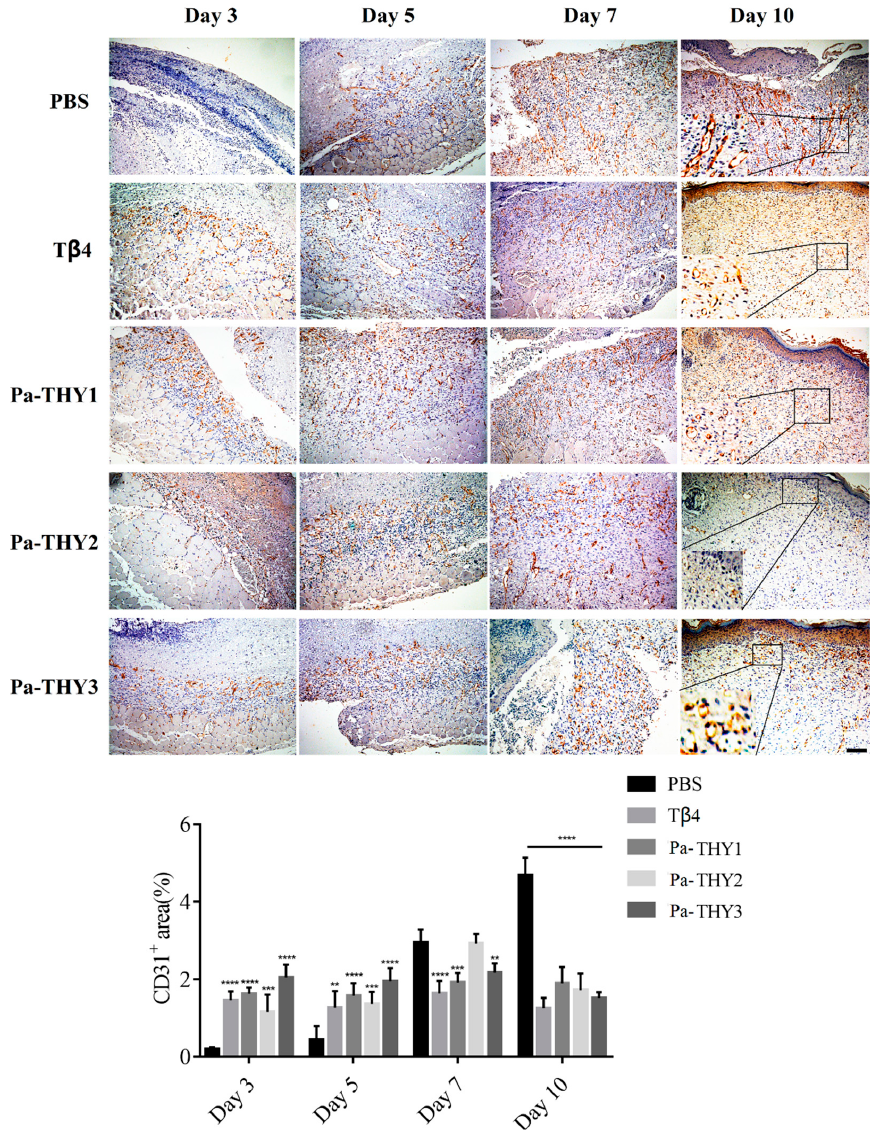
Figure 7. The CD31 staining of wound areas in dermal tissues treated with T β 4 and Pa-THYs proteins (scale bar = 200 μ m, ×100). All the groups compared to PBS group in certain time point, (scale bar = 200 µ m, × 100). All the groups compared to PBS group in certain time point, two-way two-way ANOVA analysis,; ** p < 0.01; *** p < 0.001; **** p < 0.0001. ANOVA analysis,; ** p < 0.01; *** p < 0.001; **** p <